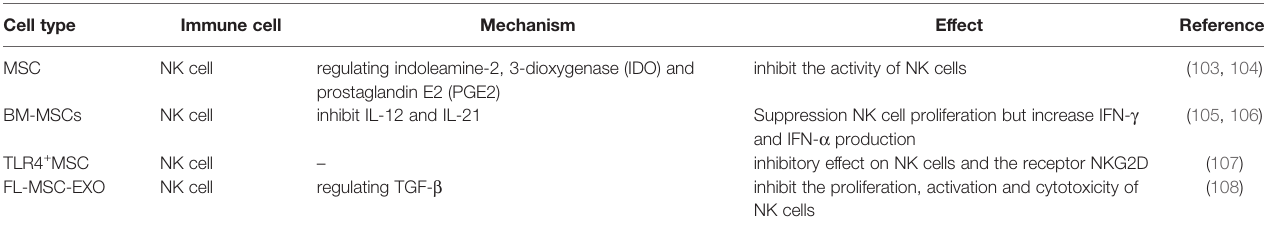
TABLE 4 | Mechanism of action with MSCs and EVs on NK cell.